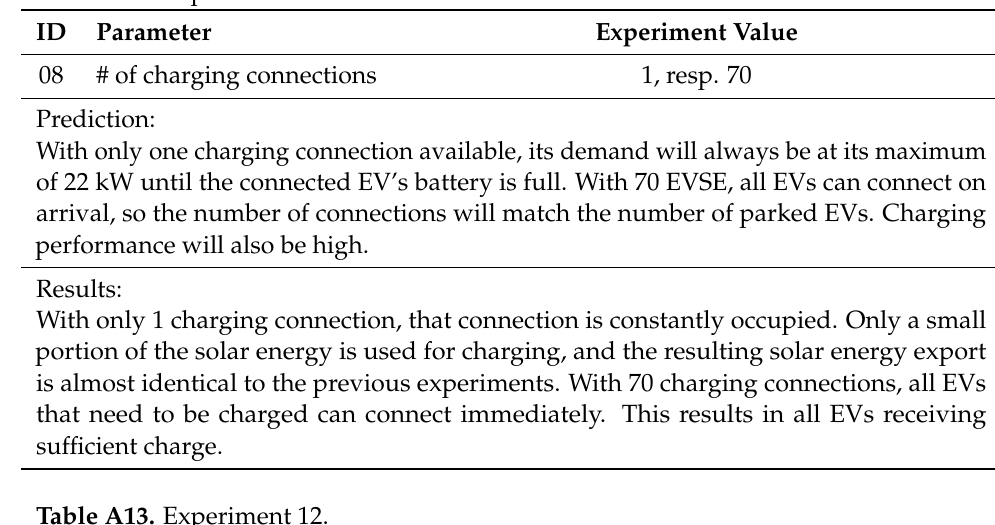
Table A12. Experiment